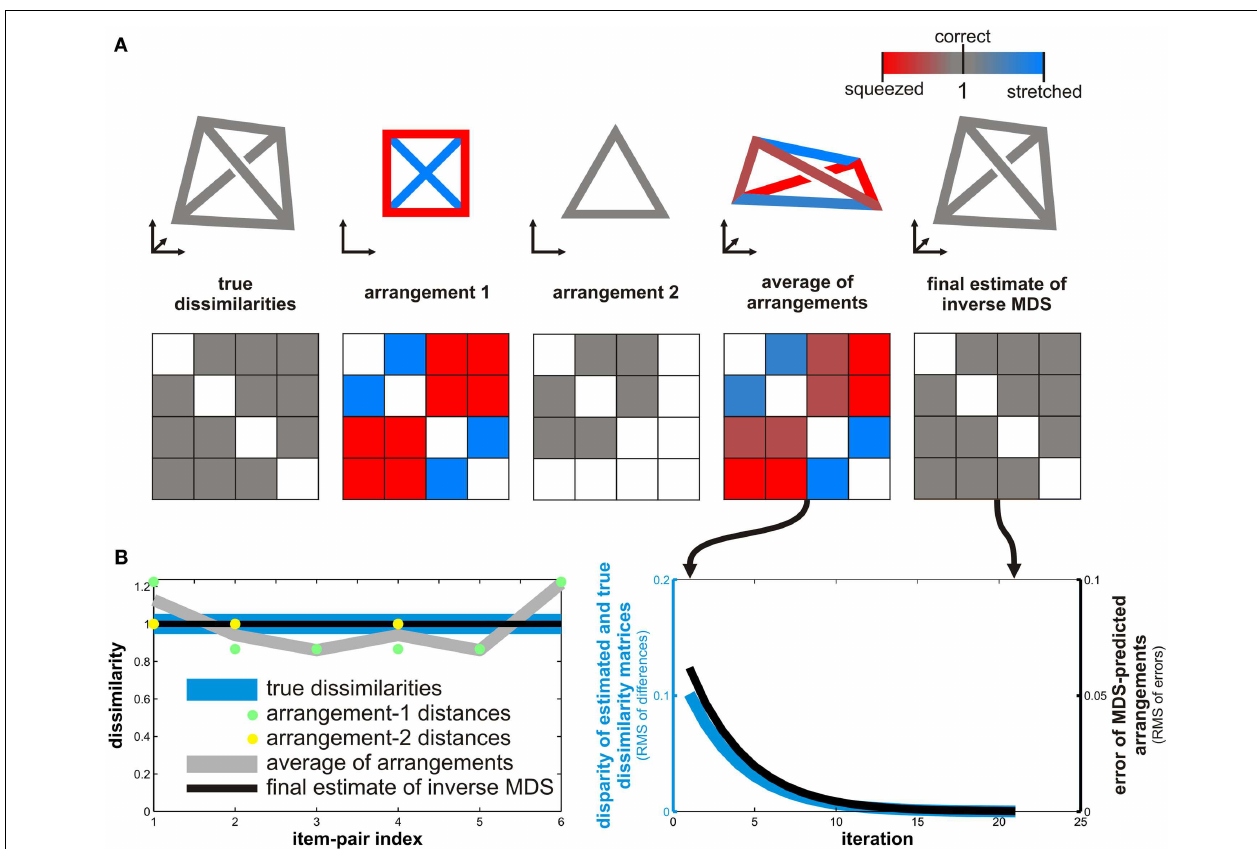
square for the defined entries to the same value. (B) Results of iterative inverse MDS for the toy problem.The aligned-average RDM (gray line in left panel) is a better estimate of the true dissimilarities (blue line) than the distance matrix of arrangement 1 (green dots), but distortions remain. Inverse MDS can be performed by starting from the aligned-average matrix and iteratively improving the estimate. On each iteration, the current estimate is used to predict the subject’s arrangements by MDS. The disparities between the predicted and the actual arrangements are then used to adjust the estimate of the underlying RDM.The resulting iterative reduction of the error of the MDS-predicted arrangements (black line in right panel) reduces the disparity between the true and the estimated dissimilarity matrices (blue line in right panel; disparity measured as root mean square of differences after normalization of both matrices). In this toy example, the two arrangements shown suffice to perfectly recover the tetrahedral true RDM (black line in left